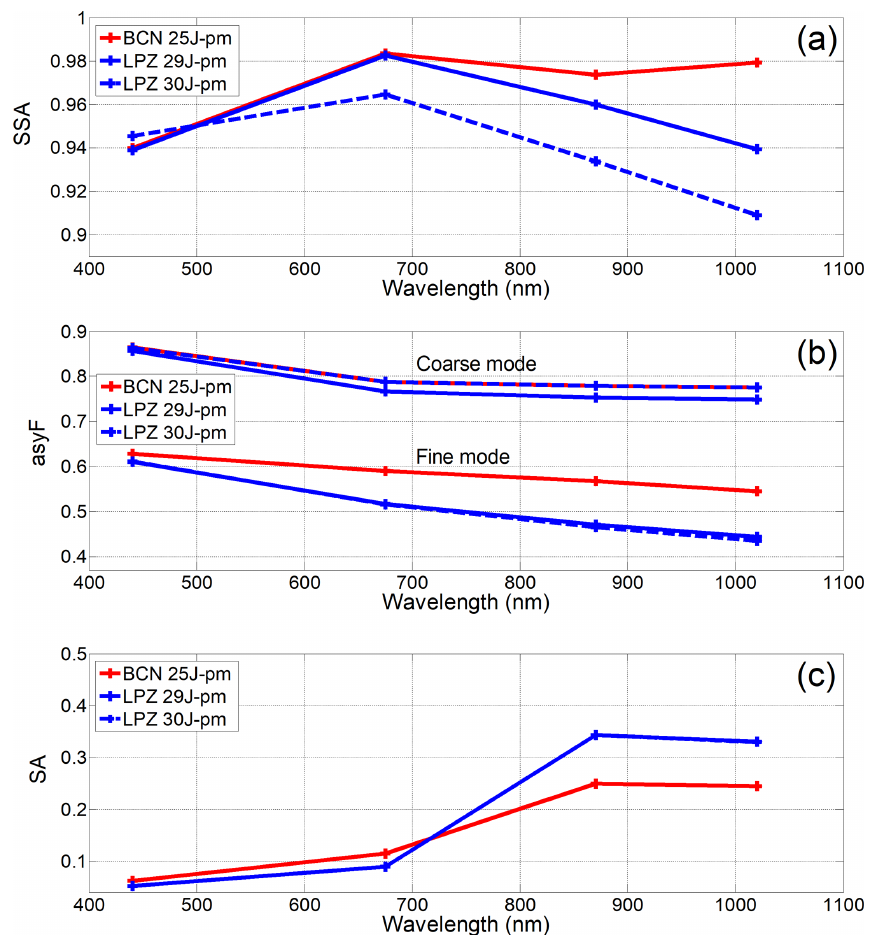
Figure 6. AERONET spectral behaviour of (a) SSA, ( b ) asyF, and (c) SA for BCN (red lines) on 25 June afternoon (25J-pm) and for LPZ (blue lines) on 29 and 30 June afternoon (29J-pm, solid lines, and 30J-pm, dashed lines,